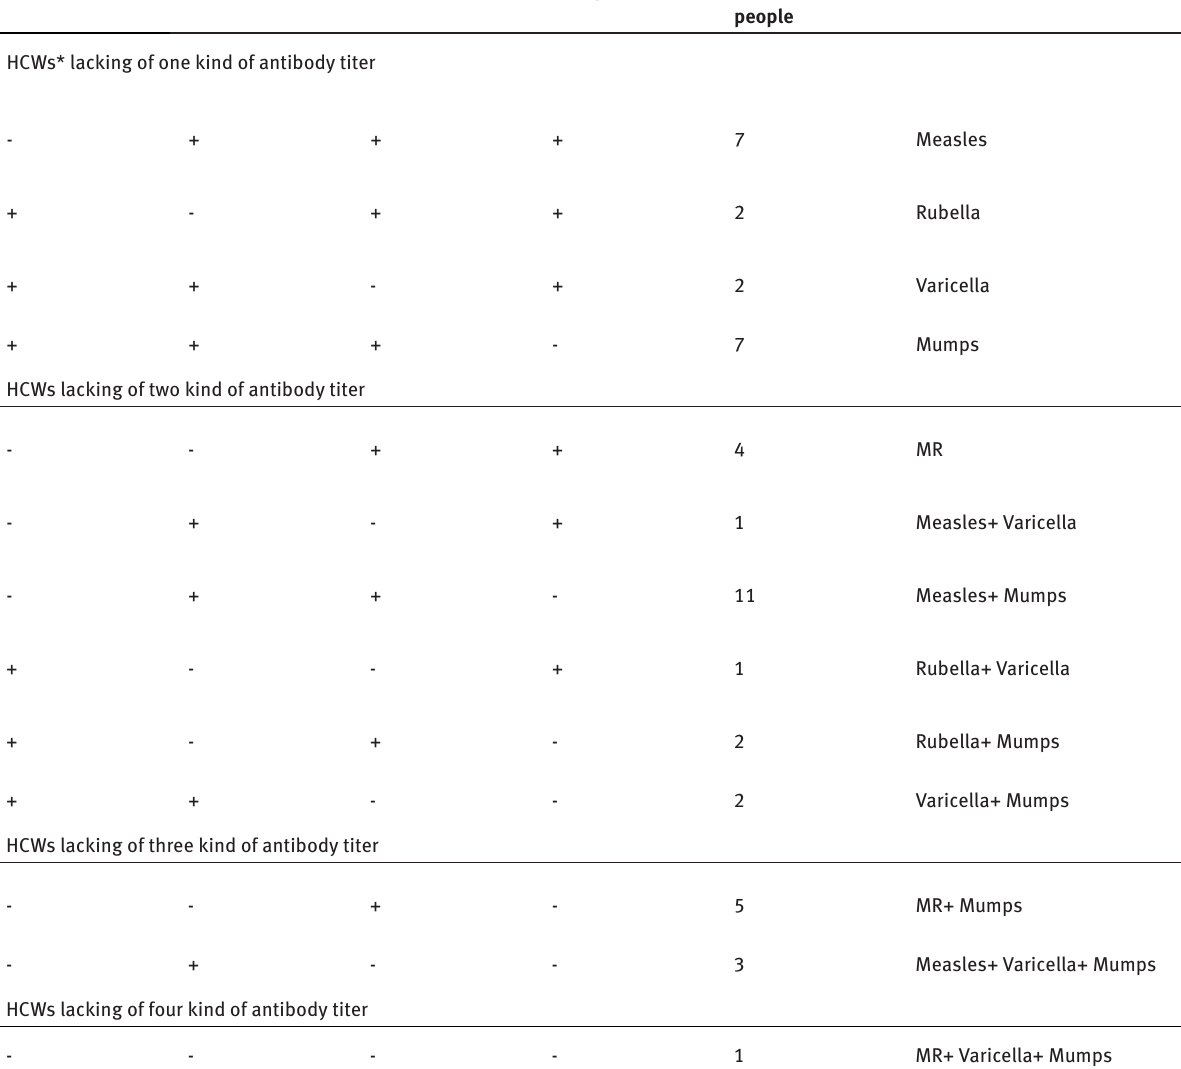
Measles Rubella Varicella Mumps Number of